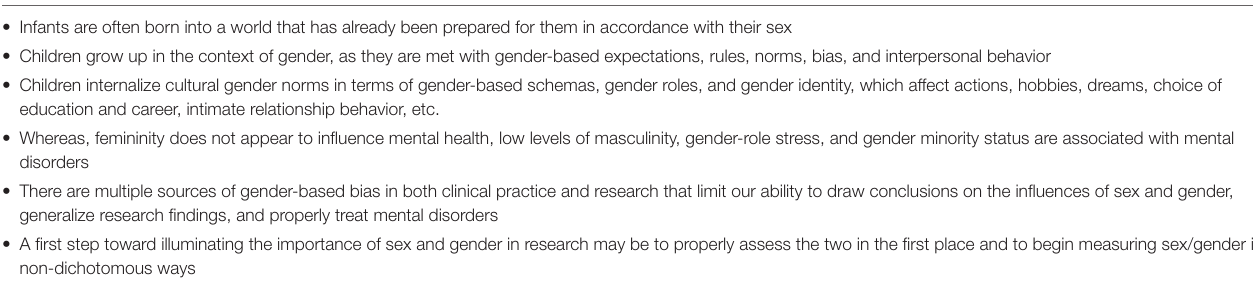
TABLE 3 | Summary of gender-based theories.